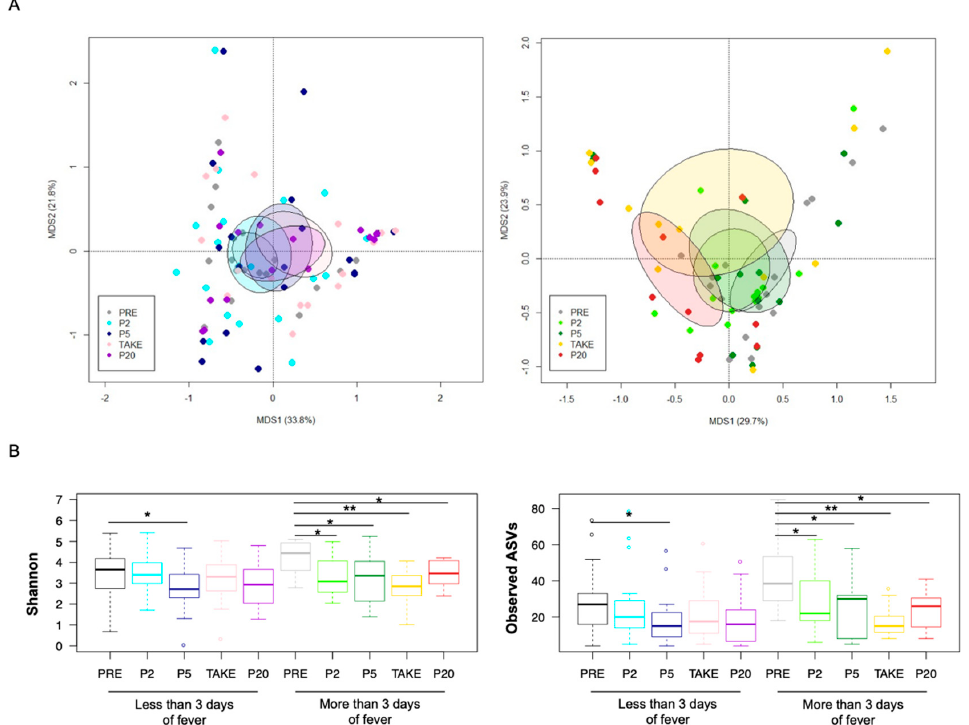
Figure 2. Gut microbiota diversity in pediatric allo-HSCT patients with different duration of febrile neutropenia. ( A ) PCoA based on weighted UniFrac distances between the gut microbiota profiles of samples collected before transplant (PRE), at the onset of neutropenia (day − 2/+2; P2), at the onset of fever (day +4/+5; P5), at engraftment (TAKE) and after engraftment (day +20/+30; P20), in pediatric allo-HSCT patients with less than or equal to ( left ) and more ( right ) than three days of fever. Ellipses include 95% confidence area based on the standard error of the weighted average of sample coordinates. Significant separation among groups was found only for patients with longer fever duration (permutation test with pseudo-F ratio, p = 0.03). See also Supplementary Figure S2; ( B ) Boxplots showing the dynamics of alpha diversity, estimated with the Shannon index (left) and the number of observed ASVs (right), in patients with less than or equal to vs. more than three days of fever. Wilcoxon test, * for p < 0.05, ** for p < 0.01.